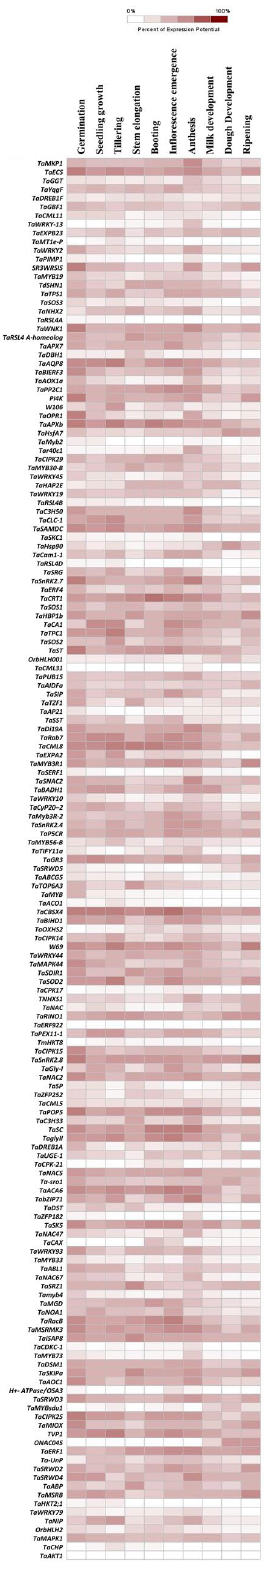
Figure 4. RNA-seq based developmental-specific expression profiles of salt stress responsive genes in wheat. The expression datasets were normalized and presented as heat maps using meta-analysis tool. The intensity of color represents the percent expression profile of the genes as described in the legend